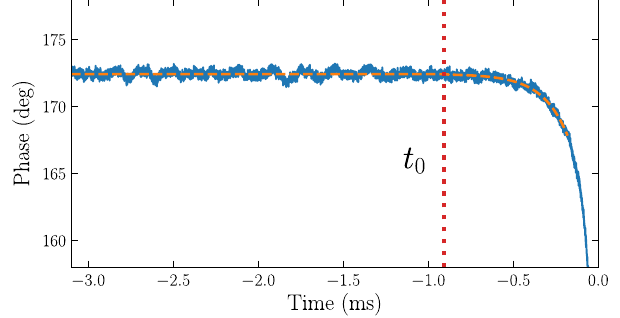
FIG. 8. The beam phase measured with the oscilloscope 2. The data were collected at the same time as those in Fig. 6, but with a longer time scale before the rf trip (at time t ¼ 0 ). The blue line indicates the measured phase, whereas the dashed line shows a fitted curve. The vertical dotted line shows an estimated onset